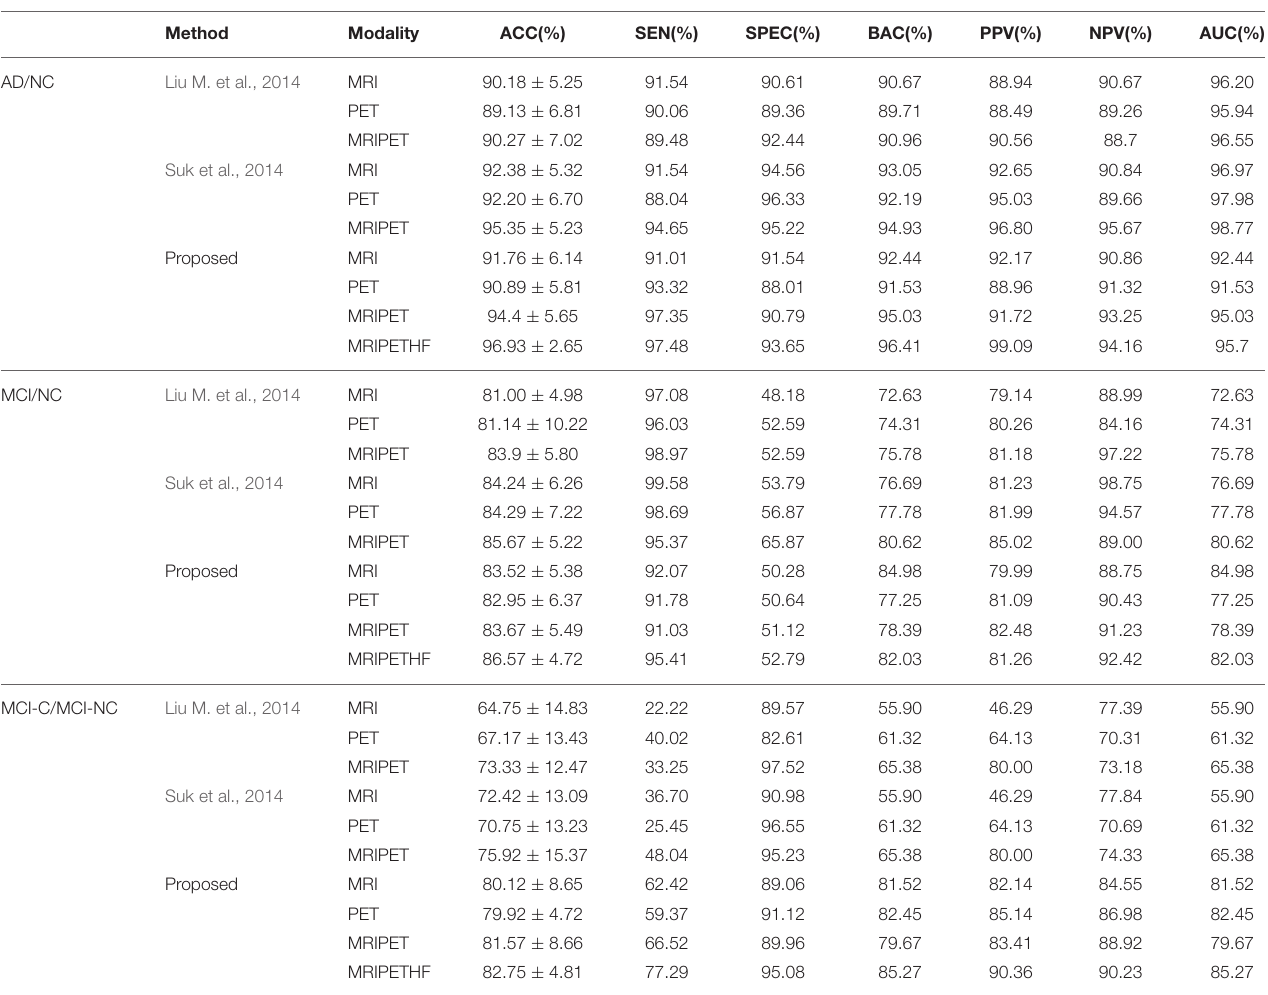
TABLE 2 | Diagnosis